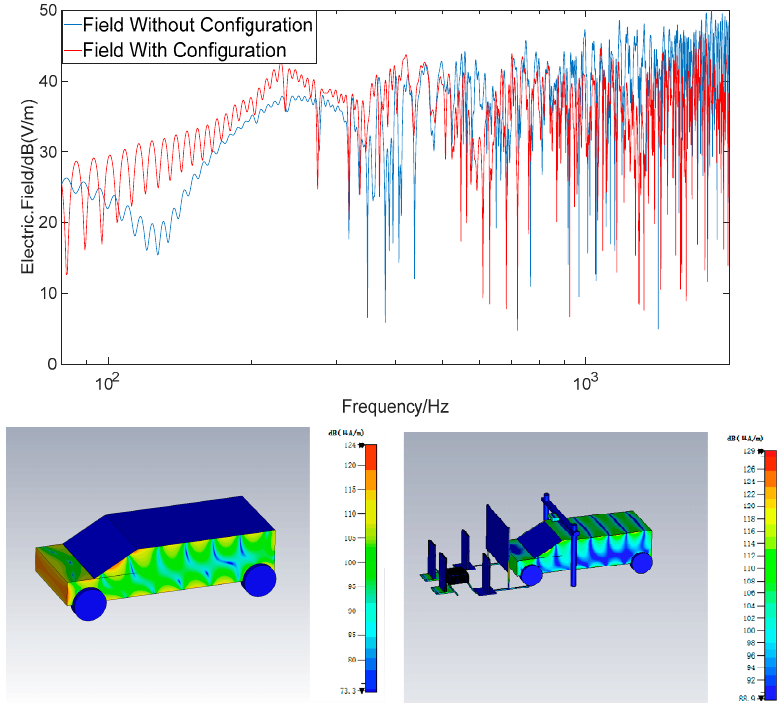
Figure 10. Electrical fields at camera point on the VUT ( top ) and surface current distribution on the VUT at 300 MHz without and with absorber walls ( bottom ).